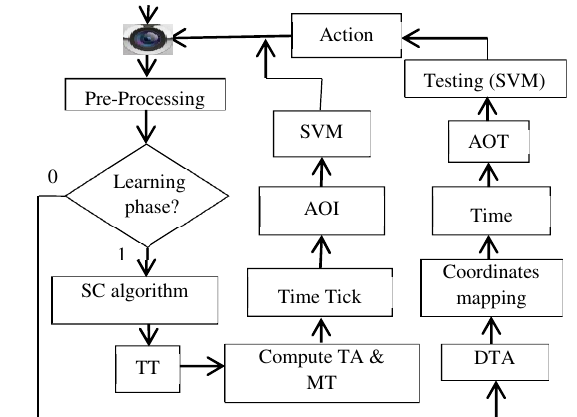
Fig.1: Schematic of the Time